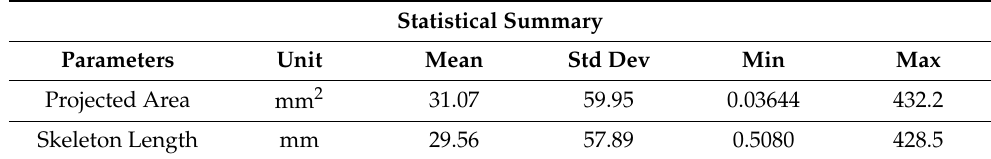
Table 1. Mean and standard deviation of TiO 2 scaffolds.